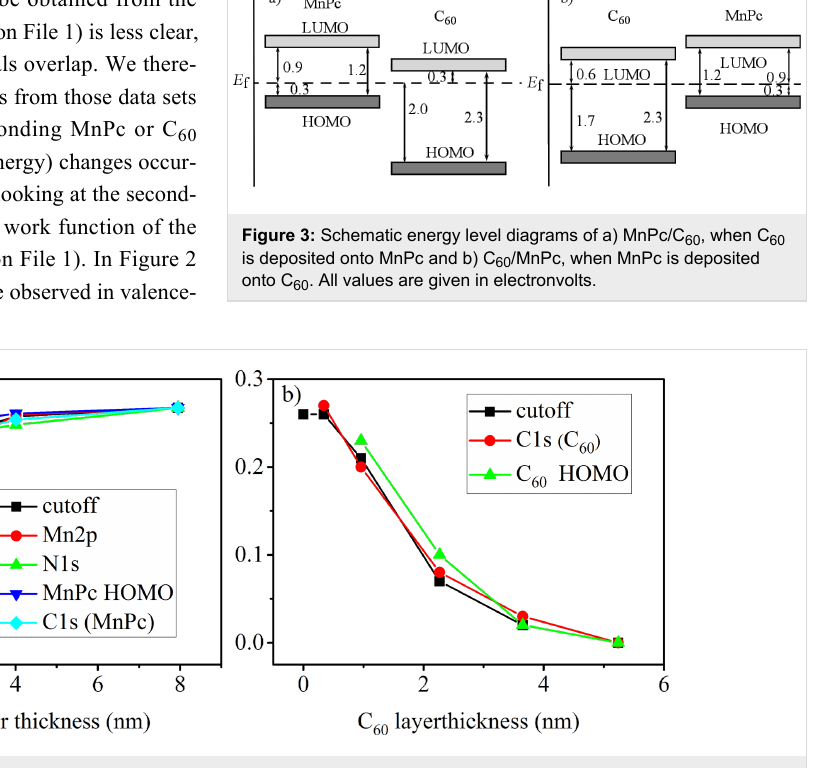
Figure 2: Comparison of the energy shifts of core levels, valence-band features and the secondary-electron cutoff (work function) of a) the C 60 /MnPc interface and b) the MnPc/C 60 interface studied in this work.